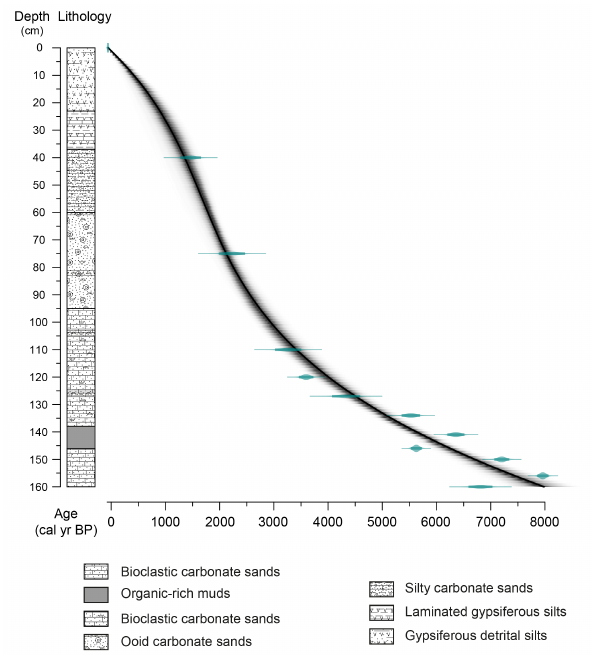
Figure 2. Lithology and age–depth model for BJM2 core. The age model was obtained by third-degree polynomial regression with 10k model iteration using the package Clam 2.2 (Blaauw, 2010). Grey scales show the distribution of all age models at 500 equally spaced core